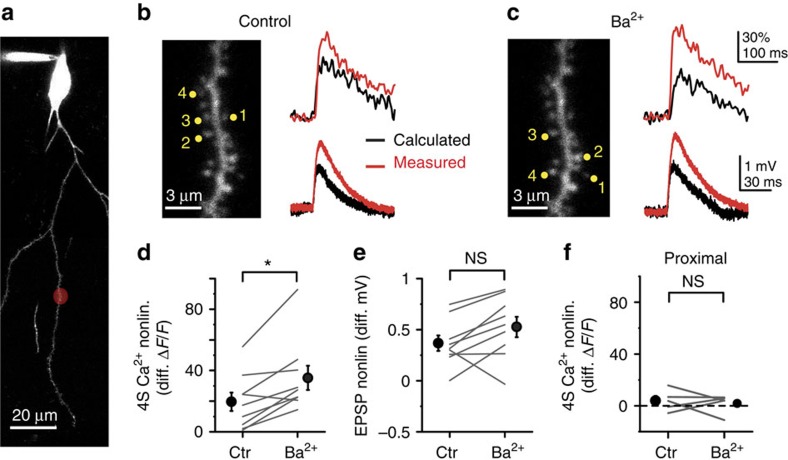
Ba2+-sensitive K+ channels regulate cooperative synaptic Ca2+ signalling.(a) Partial 2P z-stack of a basal dendrite in a CA1PC, with the stimulation site (∼30 μm distal from branch point) indicated by red spot. (b) 4S protocol on a set of four spines under control conditions at the stimulation site shown in (a). Left: stimulated spines. Right: spine Ca2+ signals (upper, averaged data from the four spines) and somatic EPSP (lower). Black traces: calculated responses; red traces: measured responses. (c) 4S protocol on another nearby spine set in the same segment (s3 is the same as s2 in b) after bath application of 250 μM Ba2+. (d) Summary of the effect of 200–250 μM Ba2+ on spine Ca2+ nonlinearity (n=9, P<0.05, Wilcoxon test). Grey lines represent individual dendrites, where 1–2 nearby spine sets (data averaged) were measured under control versus Ba2+-treated conditions. Stimulation sites were 29±3 μm distal from the branch point, mostly at the middle of dendrites (0.53±0.05 relative distance along branch). (e) Somatic EPSP nonlinearity in the corresponding experiments (n=9, P=0.066, Wilcoxon test). (f) No effect of 200 μM Ba2+ on spine Ca2+ nonlinearity in proximal compartments (0.18±0.03 relative distance along branch, n=5, P=0.500, Wilcoxon test). Filled symbols and error bars represent mean±s.e.m. Ctr, control; nonlin., nonlinearity.